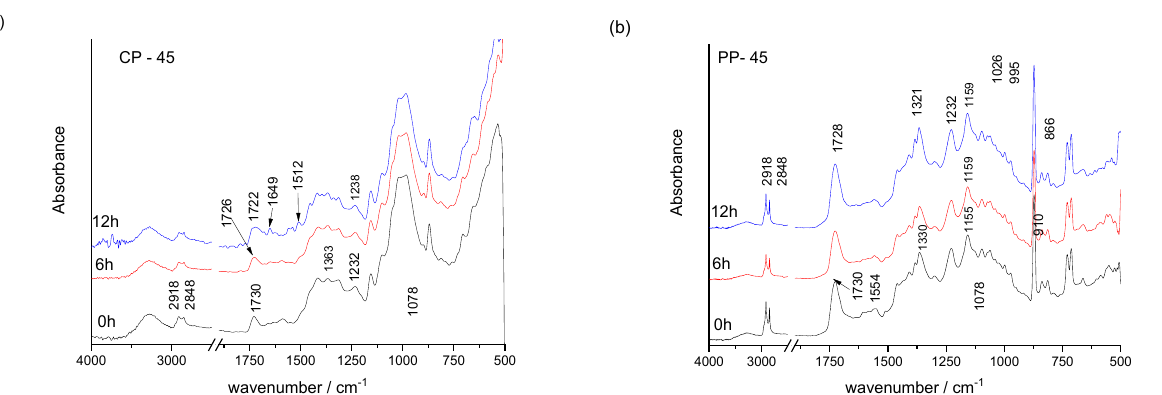
Figure 4. FTIR spectra of the TC45 ink on cellulose-based ( a ) and polypropylene-based ( b ) paper before and after exposure to UV radiation.